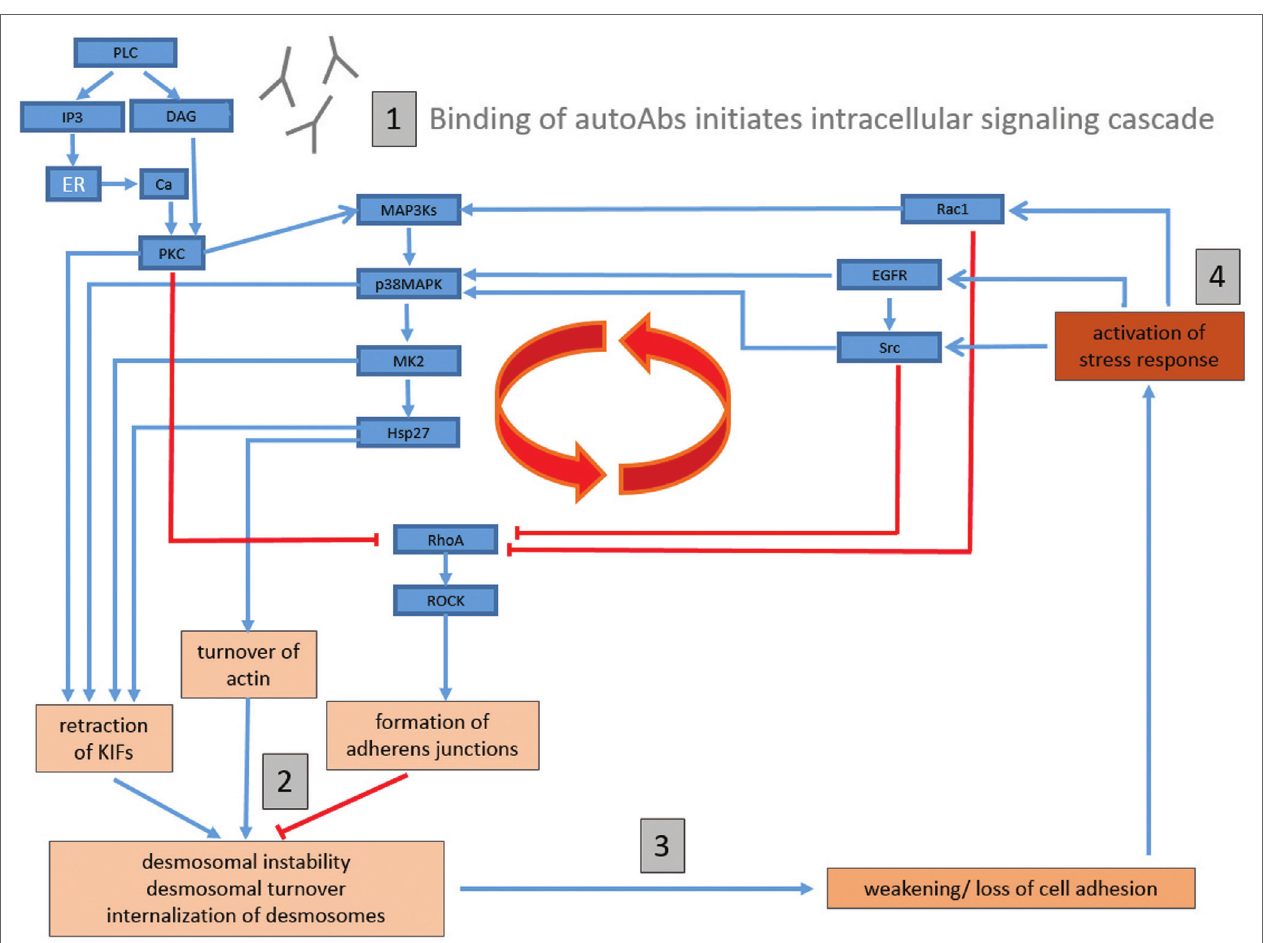
FiGURe 1 | Proposed comprehensive model of signaling mechanisms underlying blister formation in pemphigus vulgaris. (1) Binding of autoantibodies (autoAbs) to target keratinocyte antigens (either desmosomal or extra-desmosomal) induces the activation of phospholipase C (PLC), and subsequently the activation of protein kinase C (PKC) via Ca 2 + and diacylglycerol (DAG), which then activates p38MAPK via MAP3ks (such as Ask1); (2) activated PKC {either through direct phosphorylation of keratin filaments or DP} and p38MAPK { via MAPKAP2 (MK2) and heat-shock protein (Hsp)27 phosphorylation} then induce the retraction of the KIFs as well as the turnover of the actin cytoskeleton; (3) the retraction of KIFs from the desmosomal plaques, as well as cytoskeletal rearrangements, then cause a destabilization of desmosomes, and a weakening of cell adhesion; (4) finally, the weakening of cell adhesion, coupled with the mechanical stress induced by cytoskeletal rearrangements, induces a cellular stress response, resulting in the activation of Src, epidermal growth factor receptor (EGFR), and Rac1 (as well as other pathways), and re-initiation/perpetuation of the pathological cycle. RhoA is inhibited by multiple pathways (such as PKC, EGFR/Src, and Rac1). As RhoA activation has been shown to inhibit PVIgG-induced acantholysis, an inhibition of RhoA would promote cell dissociation. Blue arrow-headed lines indicate activation, while red bar-headed lines indicate inhibition of selected